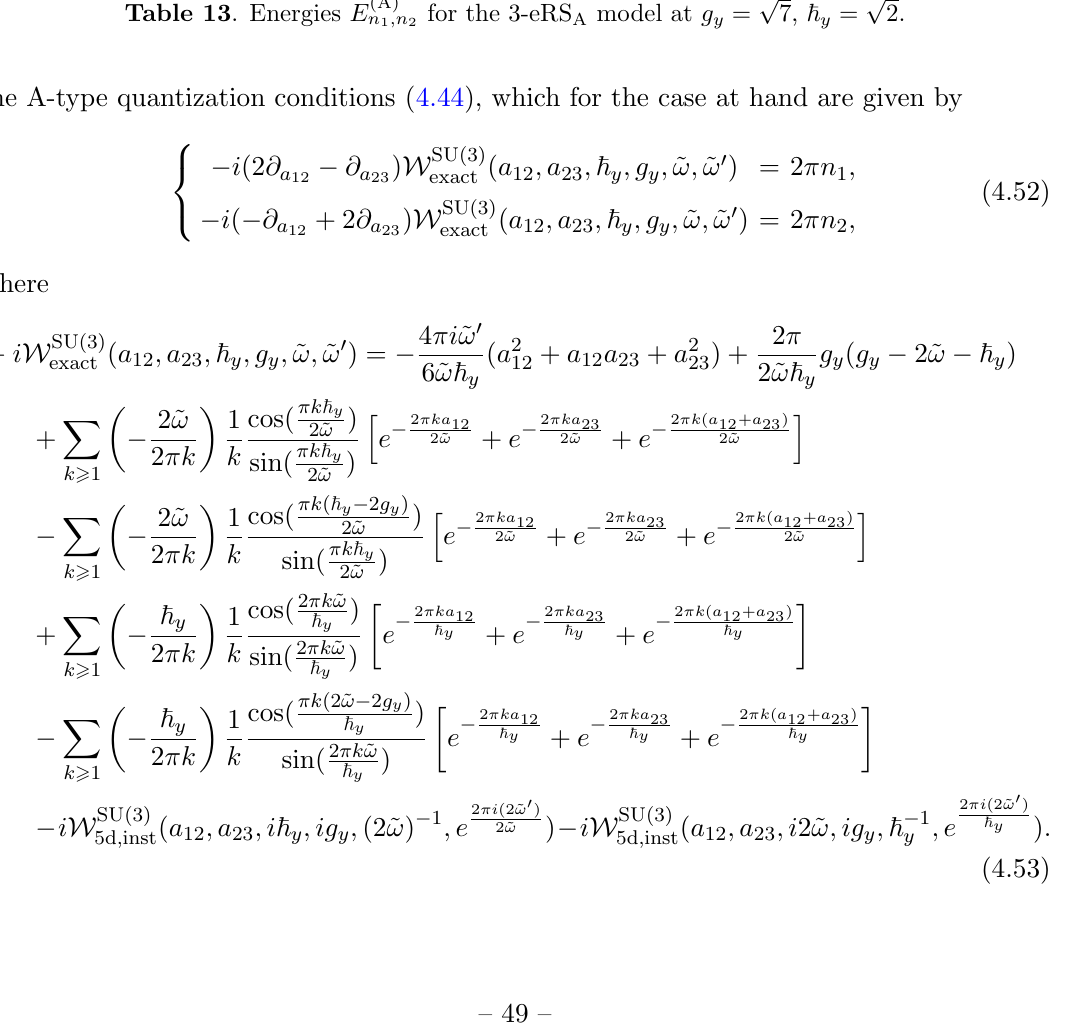
Table 13 . Energies E (A) n